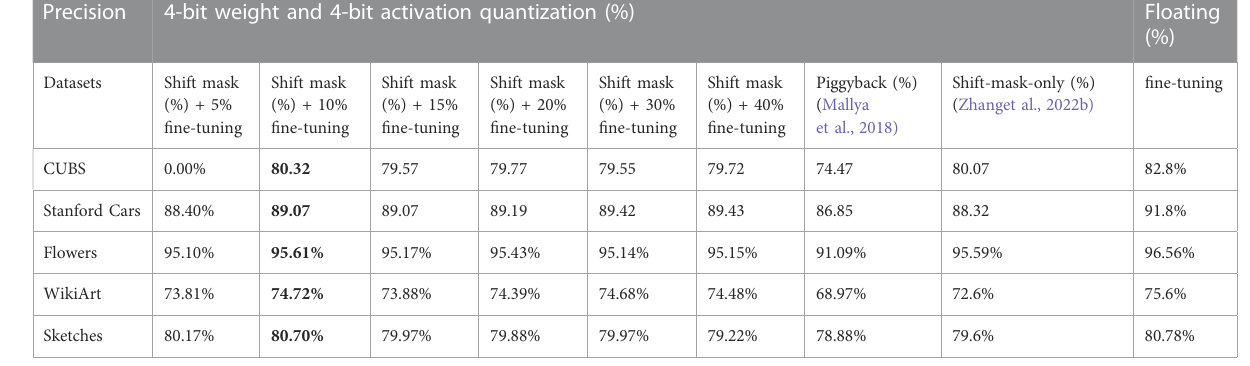
TABLE 3 Multi-task adaption accuracy (%).